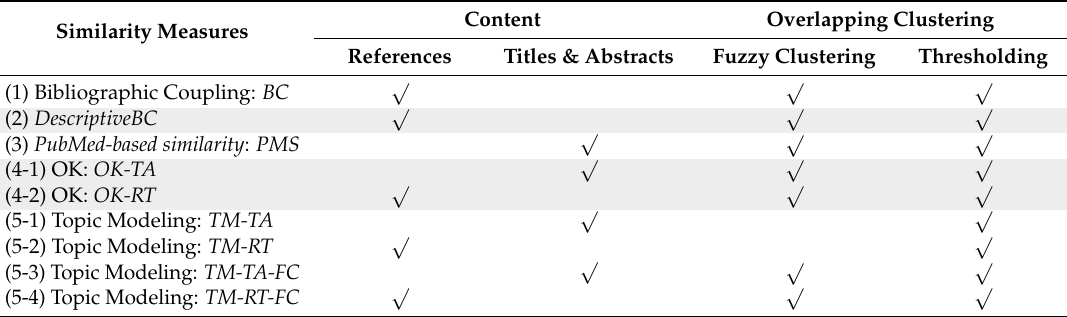
Table 2. Systems for overlapping clustering with various inter-article similarity